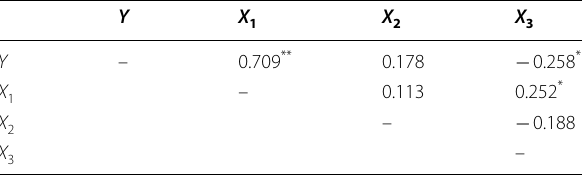
* and ** represent significance at 5 and 1 percent levels, respectively. Denotations of variables are as follows: